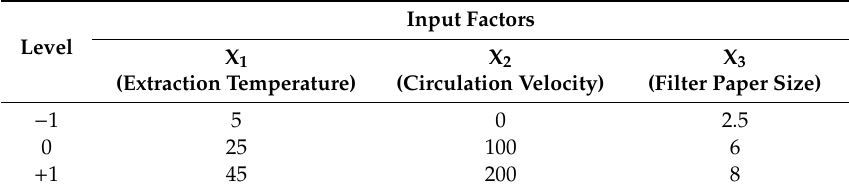
Table 2. Level and range of IVs.